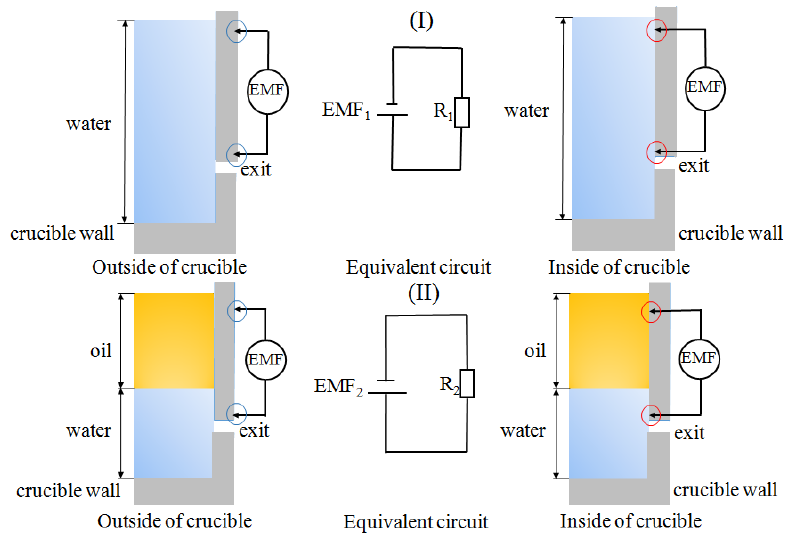
Figure 1. Schematic diagram of water (I) and water oil (II) measuring system.